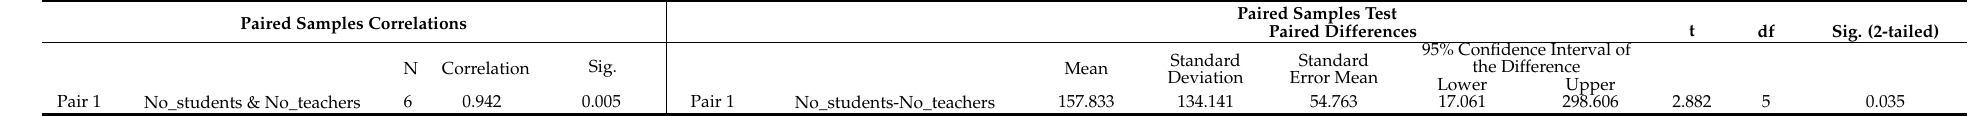
Table 26. Paired samples t-test applied for the perspective of teachers and perspective of students on online teaching methods. Paired Samples Correlations